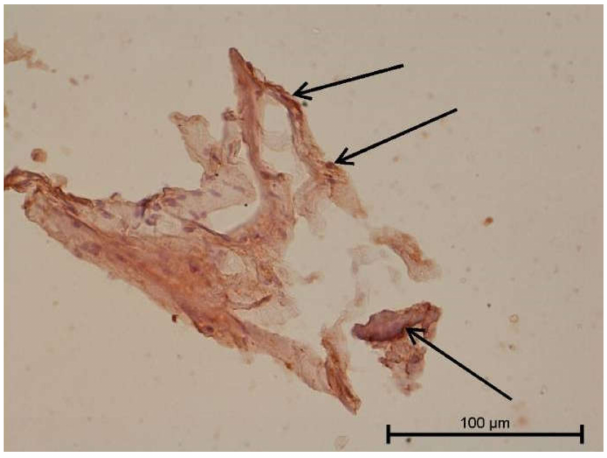
Figure 17. Light microscope image. Healthy tooth. Anti-VEGFR 3—positive (black arrow). Tooth and blood vessel cells. Mag. 400 × .